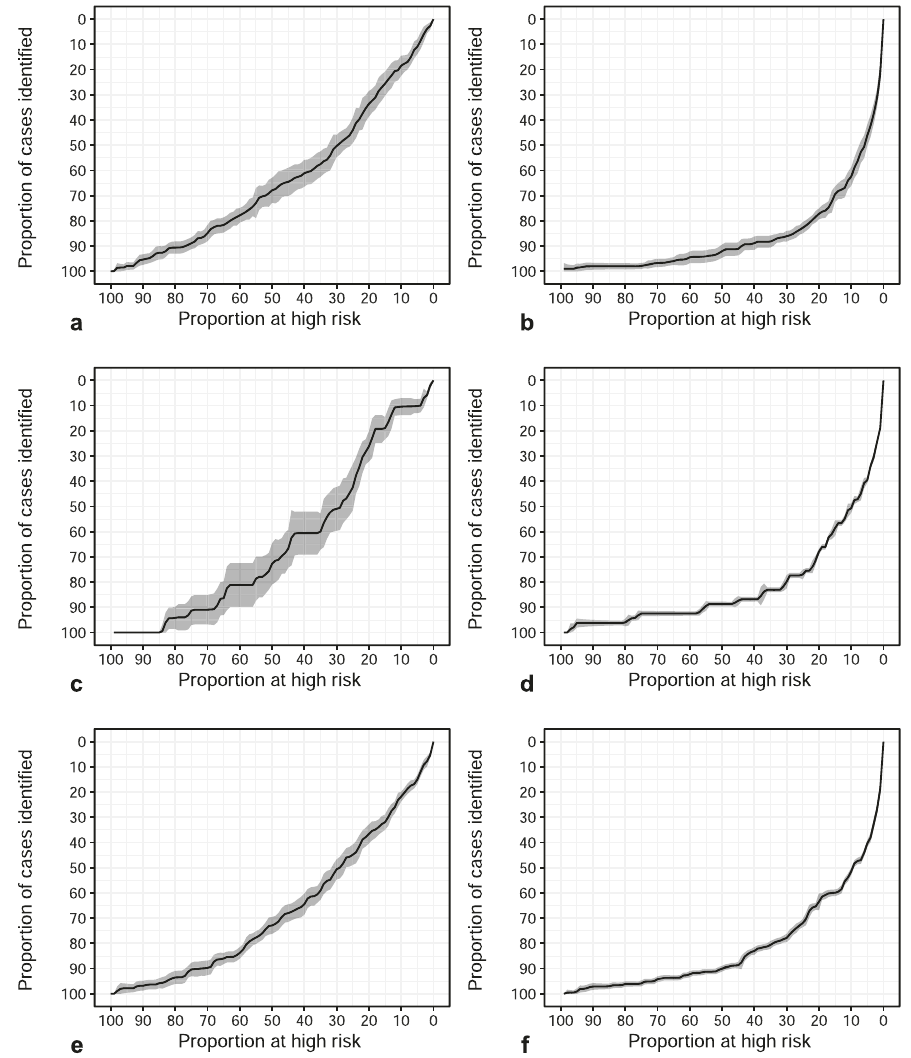
Fig. 1 Lorenz curves for the modi fi ed PRACTICAL risk score (125 SNPs) and PSA in each of the MDC, VIP at age 50, and VIP at age 60 cohorts. a PRS in MDC. b PSA in MDC. c PRS in VIP age 50. d PSA in VIP age 50. e PRS in VIP age 60. f PSA in VIP age